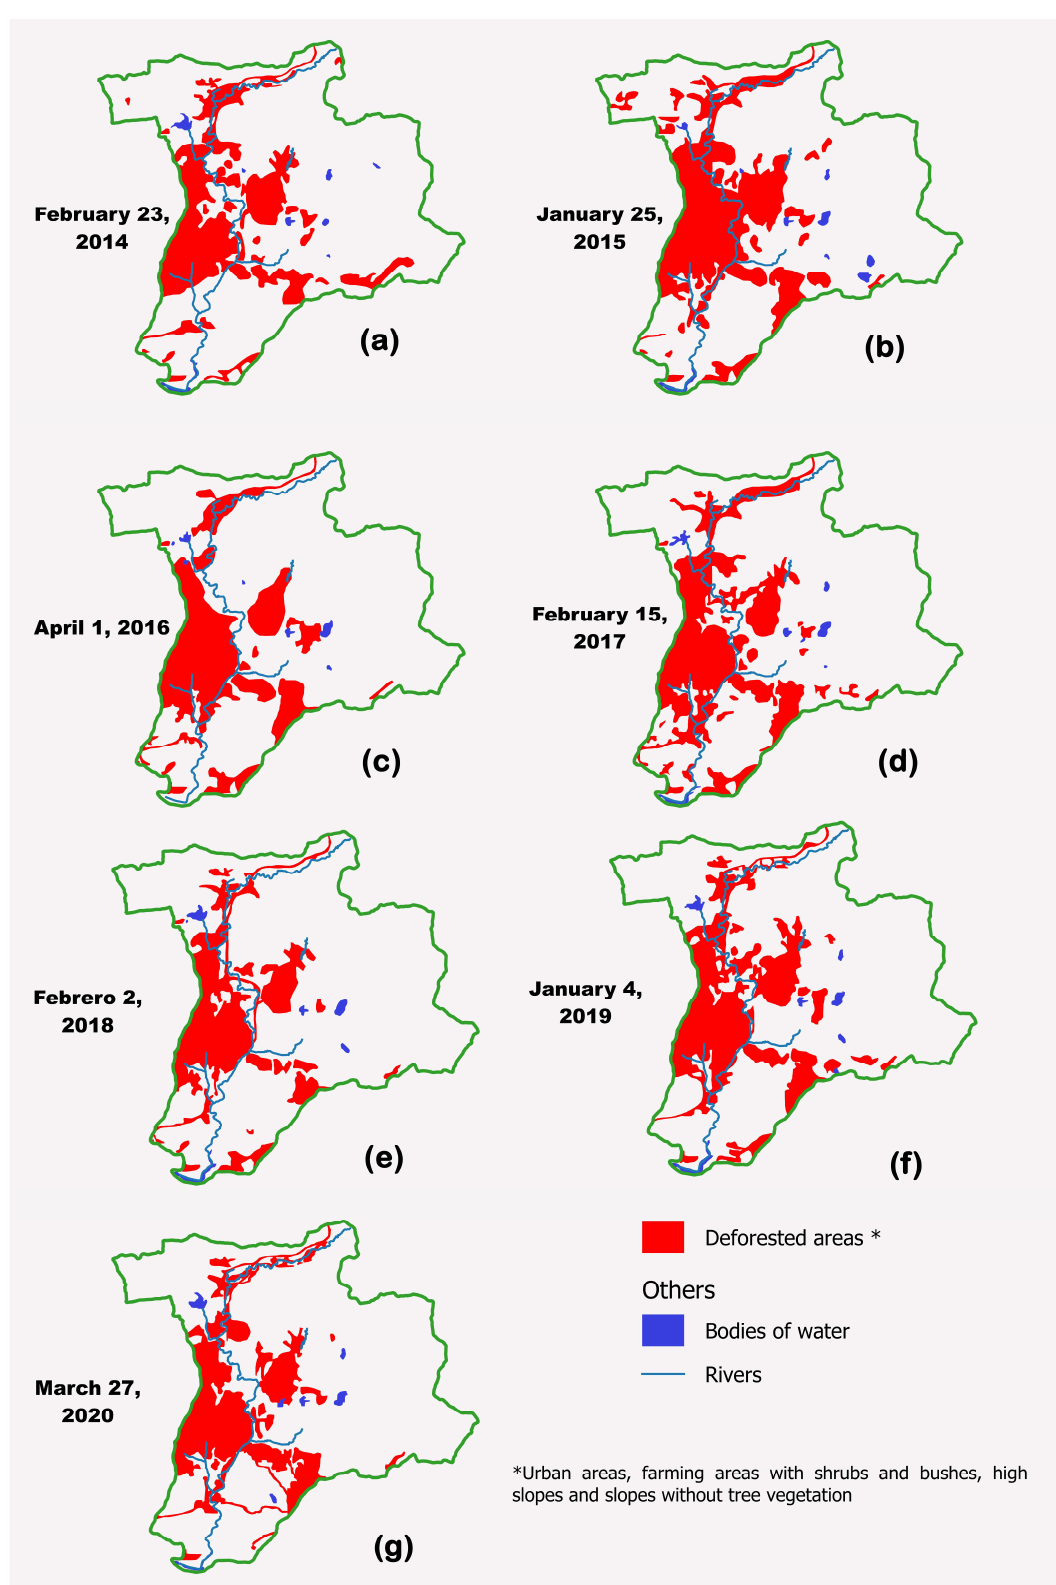
Figure 5. Visual classification of deforestation by years. ( a ) Year 2014. ( b ) Year 2015 ( c ) Year